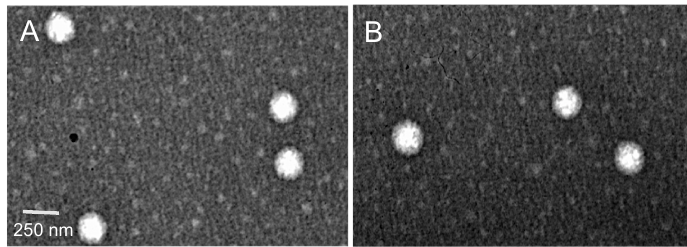
Figure 2. Transmission electron microscopy images of ( A ) NLCs and ( B ) RPT-loaded NLCs, at 50,000× magnification. The white bar represents 250 nm.